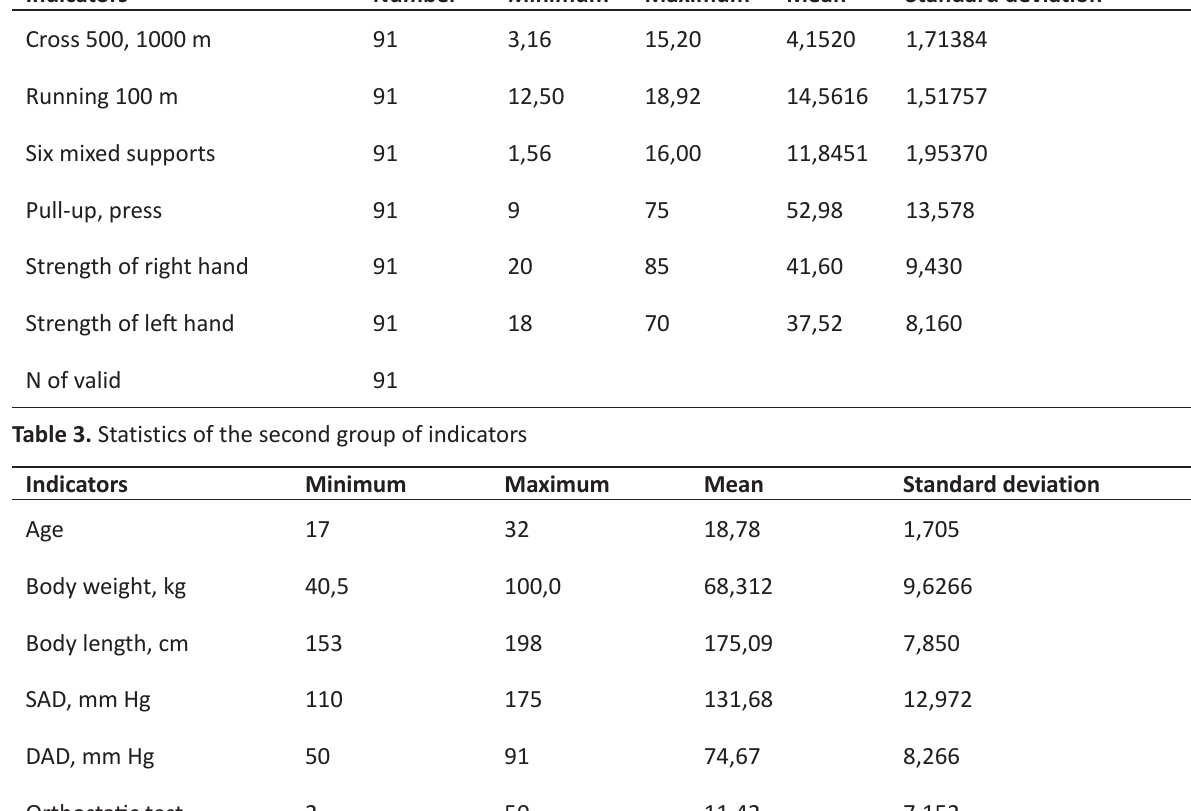
Table 2. Statistics of the first group indicators Indicators